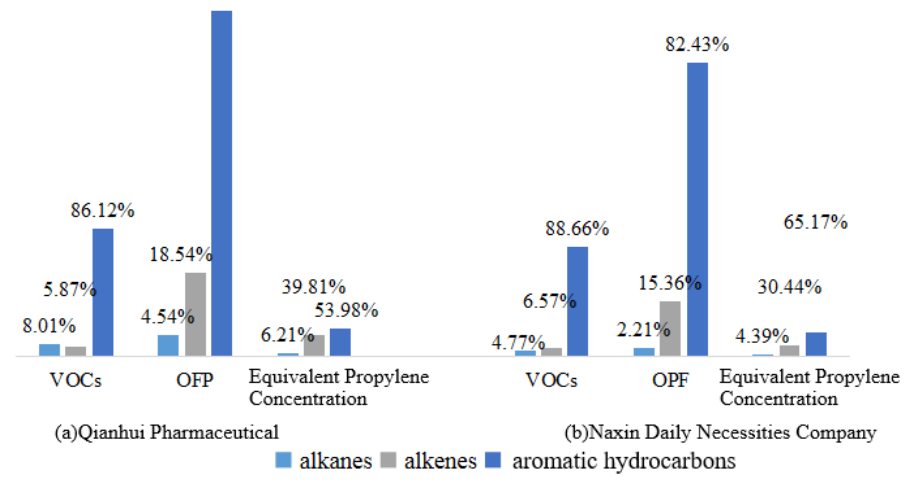
Figure 8. The VOC distributions, the OFP values, and the equivalent propylene concentration percentages of alkanes, alkenes, and aromatic hydrocarbons. (The OPF in Figure 8 is derived from the average value of the maximum and minimum OPF in Table 2.).